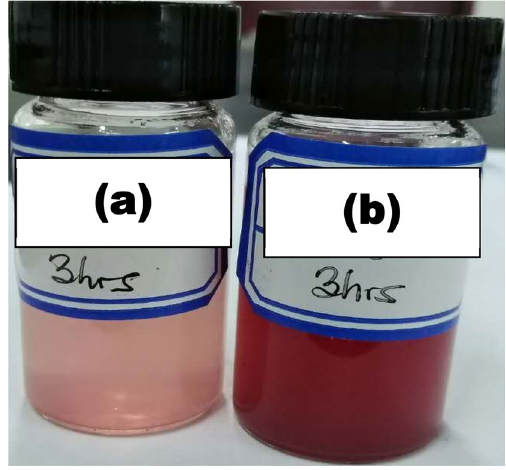
Fig. 2 Colour of a 20 mL Et-ACPE/100 mL H2O and b 20 mL ACPE/100 mL AgNO3 (Et-AgNPs) after three hours of formation of